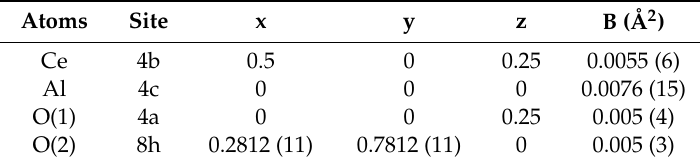
Table 2. Refined structural parameters for the as-grown CeAlO 3 crystal according to I4/mcm model.